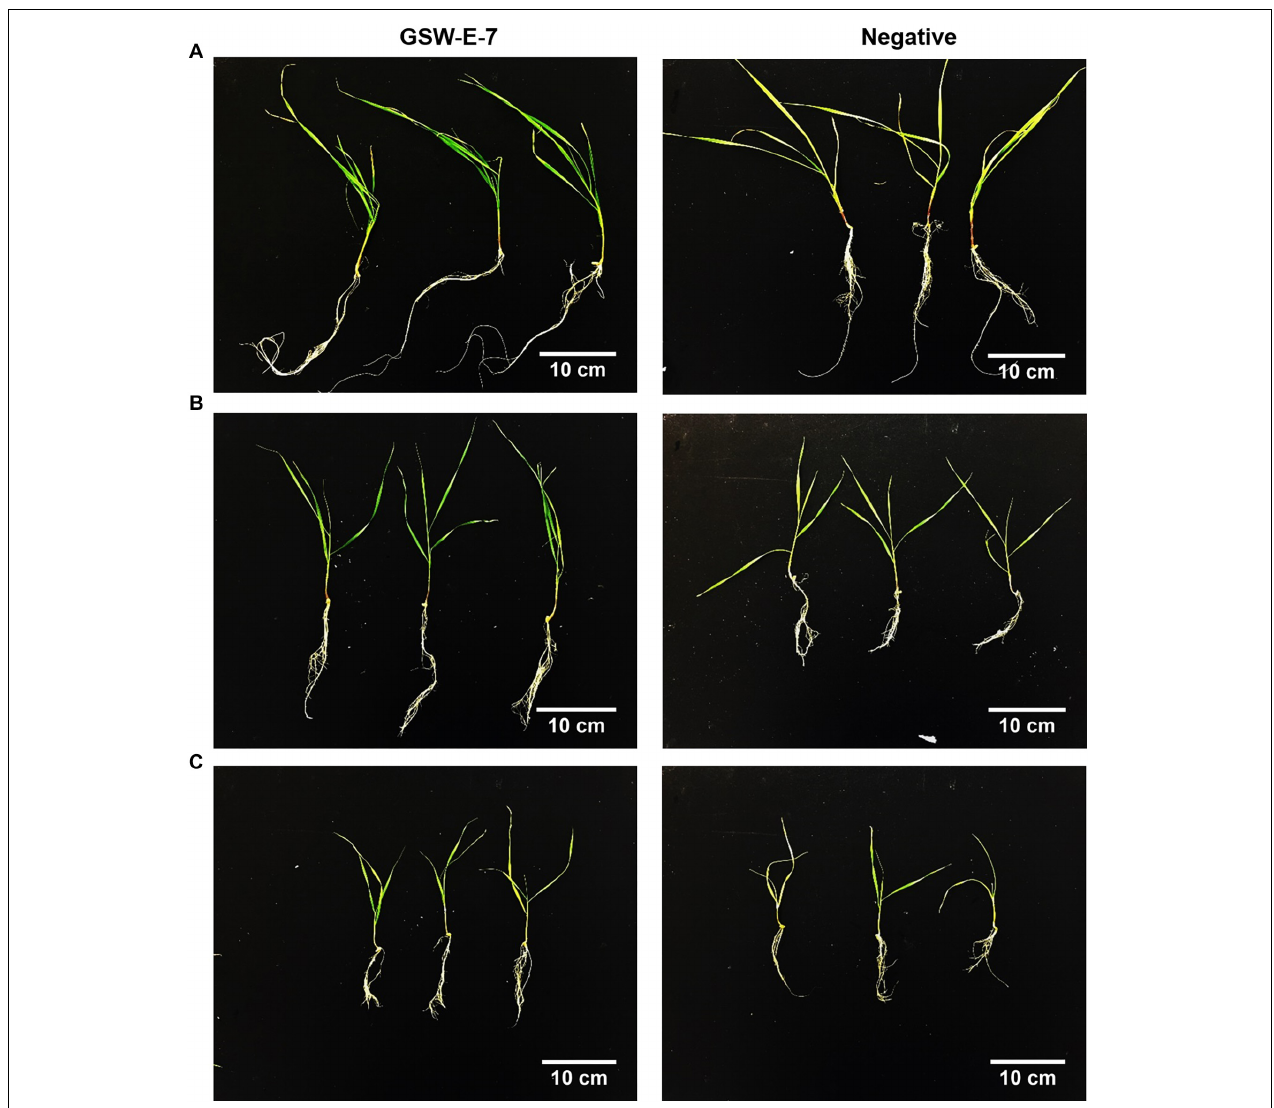
FIGURE 6 | Effect of inoculation with GSW-E-7 strain on growth of durum wheat cv. Tamaroi seedlings after 30 days of culture in hydroponic system. (A) 0 mM NaCl; (B) 80 mM NaCl; (C) 160 mM NaCl. Negative: non-inoculated